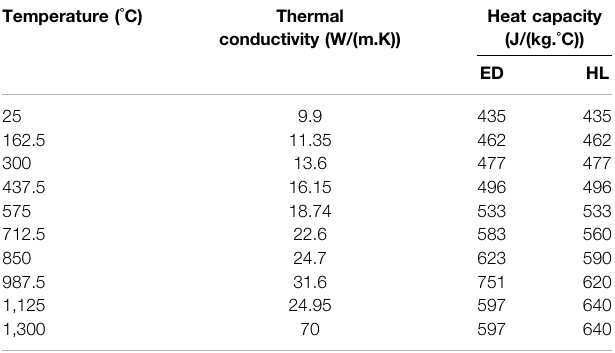
TABLE 1 | Temperature-dependent thermal material properties for R65. Temperature ( ° C) Thermal conductivity (W/(m.K))